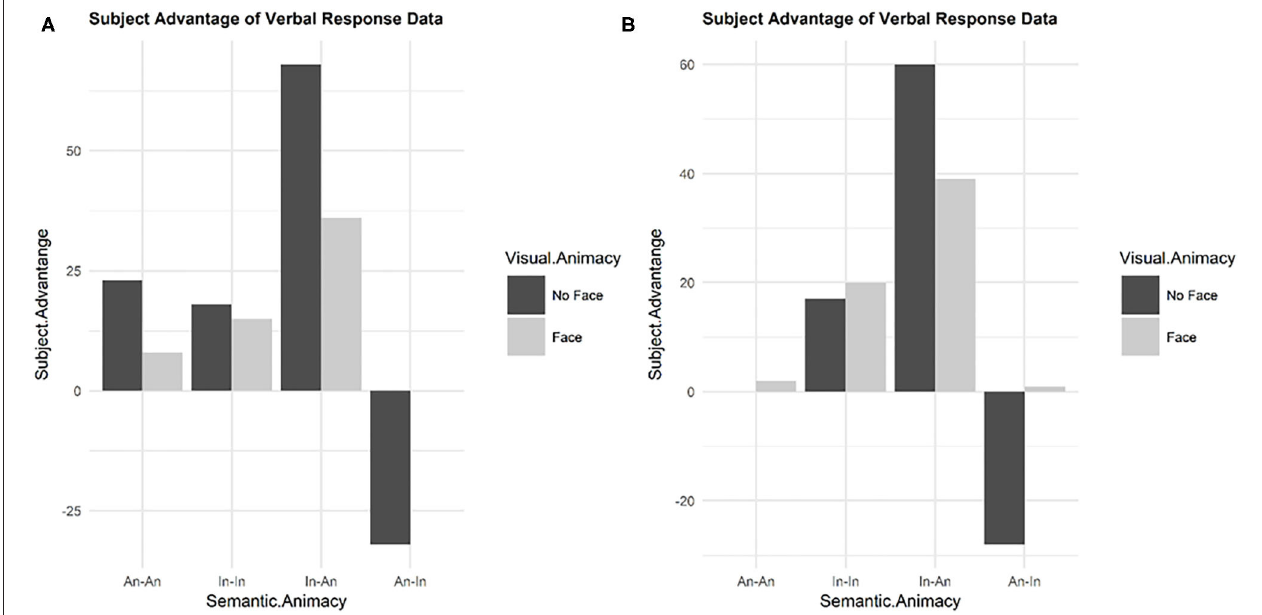
FIGURE 2 | (A) Child verbal response data. (B) Adult verbal response data. Bar height indicates the subject advantage in responses (raw number of subject responses minus object responses).